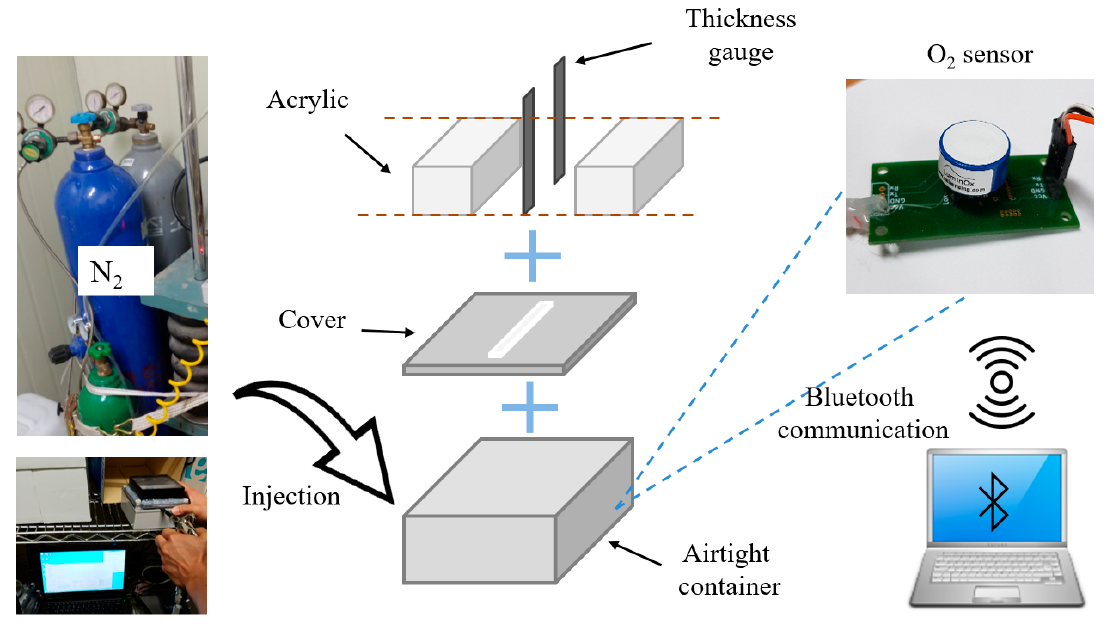
Figure 1. Outline of measurement device and method.